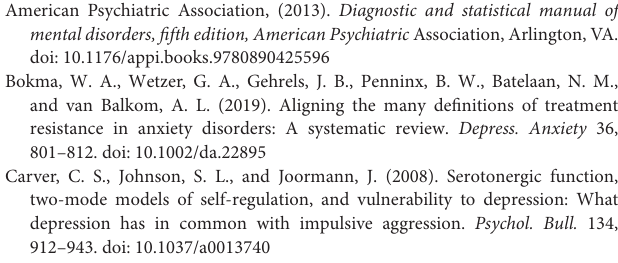
and the right inferior frontal gyrus in particular, are involved in stopping (a key output of the goal conflict system) in the stop signal task (SST). So, we used the SST and found that it generated a goal-conflict specific “theta” rhythmicity (GCSR) at F8 (Neo et al.,